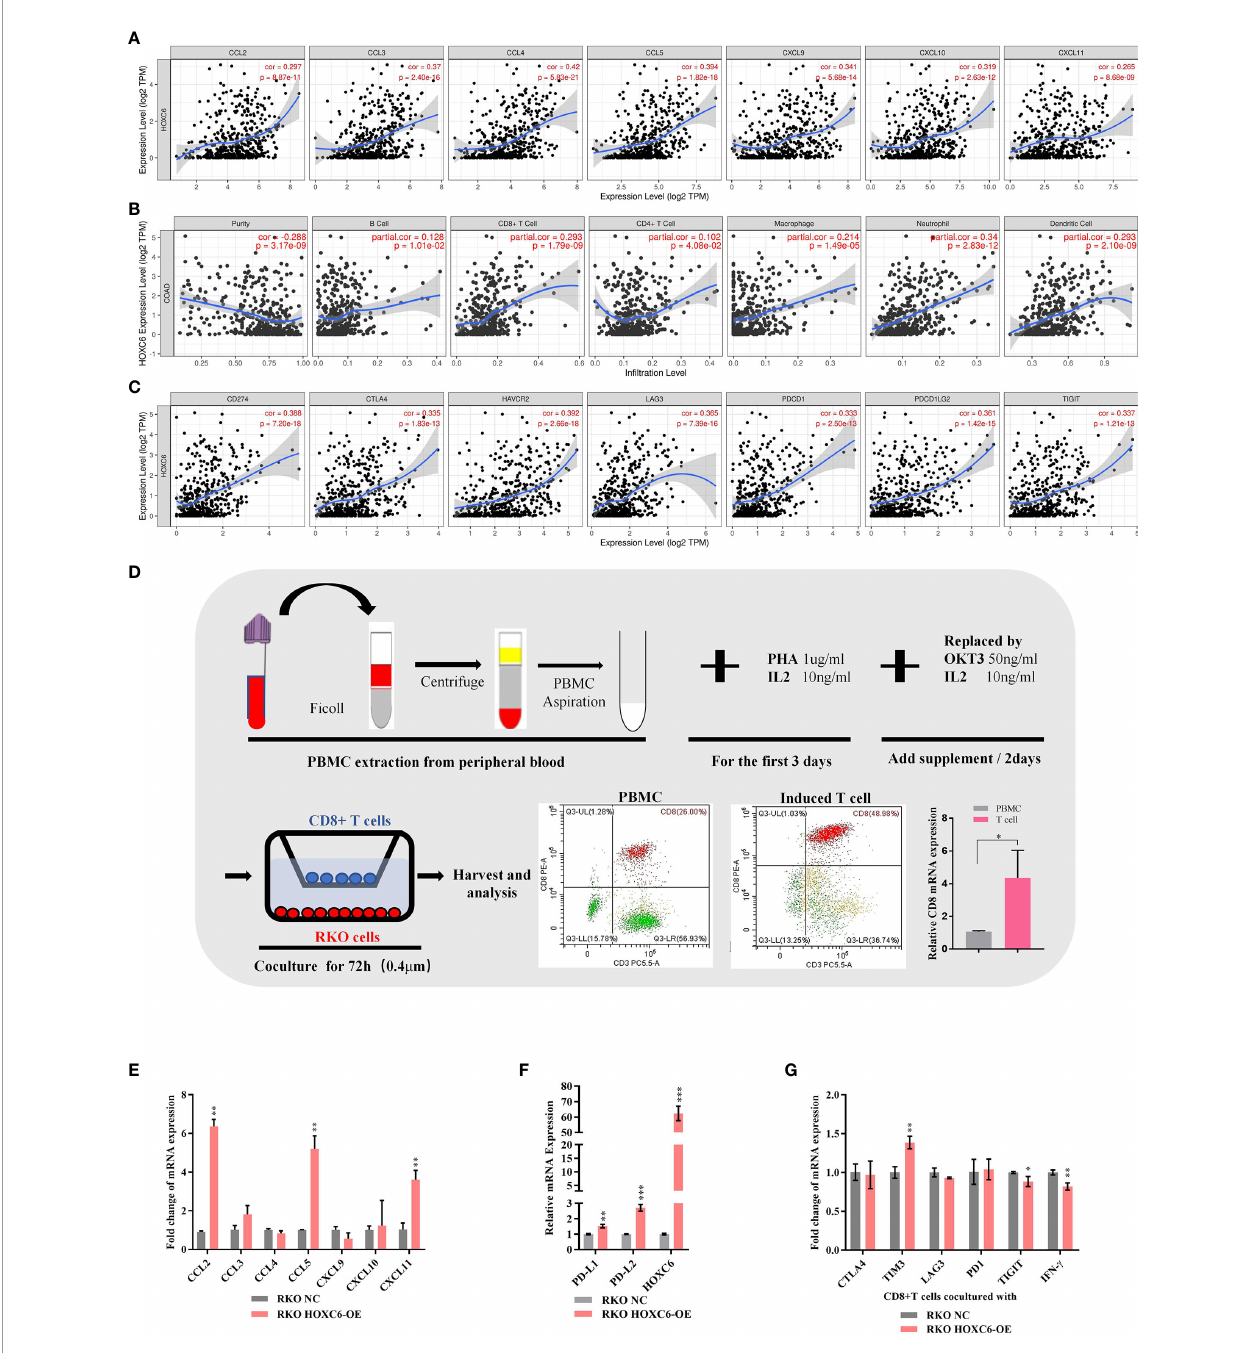
FIGURE 4 | The effect of upregulated HOXC6 on the tumor immune microenvironment in CRC. (A) Expression of HOXC6 had a signi fi cantly positive correlation with the expression of T cell attractive chemokines in the TIMER database. (B) Expression of HOXC6 had a signi fi cantly positive correlation with the in fi ltration ratio of various immune cells in the TIMER database. (C) Expression of HOXC6 had a signi fi cantly positive correlation with various immune checkpoint molecules in the TIMER database. (D) In vitro induction of CD8+ T cells from PBMCs isolated from peripheral blood and identi fi cation using fl ow cytometry and qRT- PCR. (E) The expression of CCL2, CCL5, and CXCL11 was signi fi cantly upregulated in the RKO HOXC6-OE group compared to RKO NC group (both groups were cocultured with CD8+ T cells). (F) The expression of PD-L1 and PD-L2 was signi fi cantly upregulated in the RKO HOXC6-OE group compared to RKO NC group (both groups were cocultured with CD8+ T cells). (G) Expression of TIM3 was signi fi cantly upregulated and IFN- g was signi fi cantly downregulated in CD8+ T cells cocultured with RKO HOXC6-OE group compared to RKO NC group. * P < 0.05, ** P < 0.01, *** P <